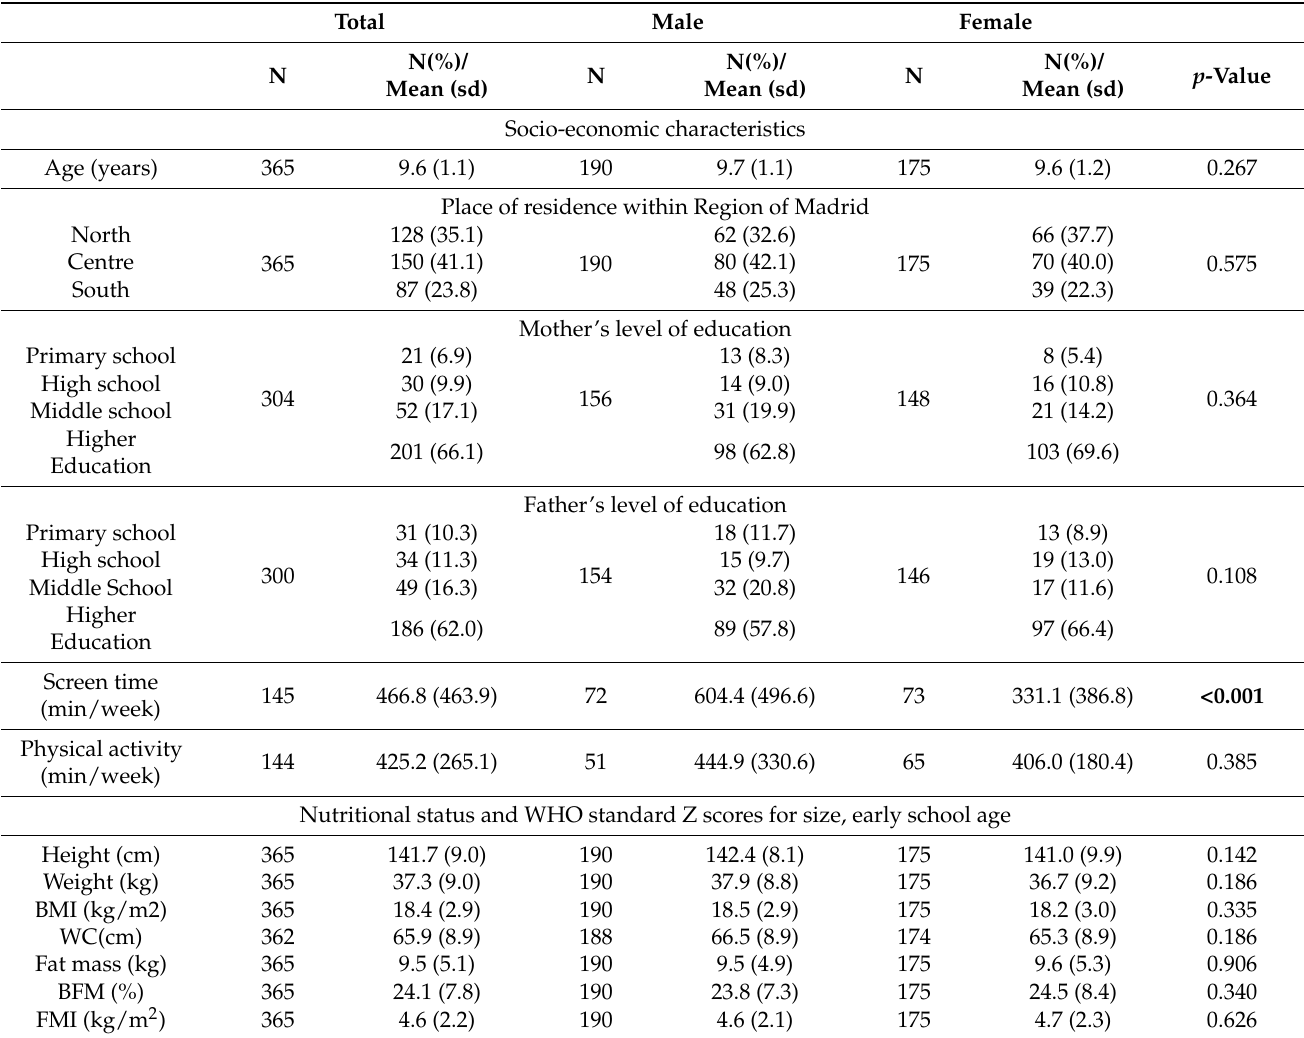
Table 1. Socio-economic characteristics, nutritional status, WHO standard Z scores for size and age, and current hemodynamic variables by